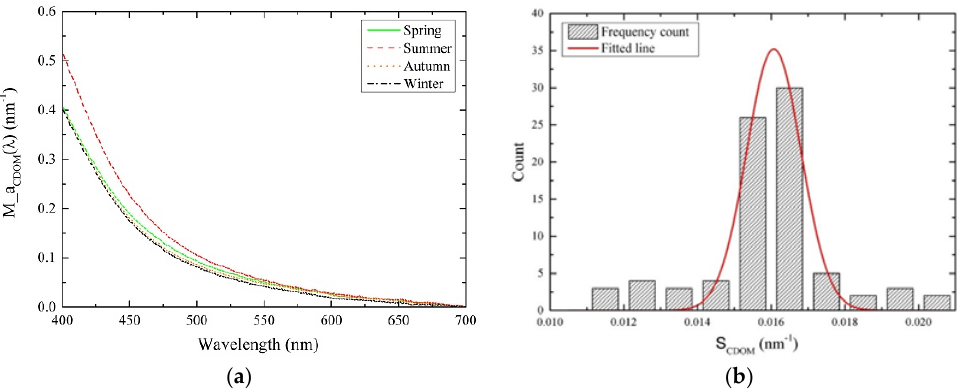
Figure 7. ( a ) Average CDOM absorption spectra of each season in Lake Qiandaohu and ( b ) frequency distribution of the slopes, S CDOM , of CDOM absorption spectra. The Gaussian curve is superimposed to illustrate the normal distribution corresponding to the average value of S CDOM (0.0164 nm − 1 ), with standard deviation (0.00176 nm − 1 ).